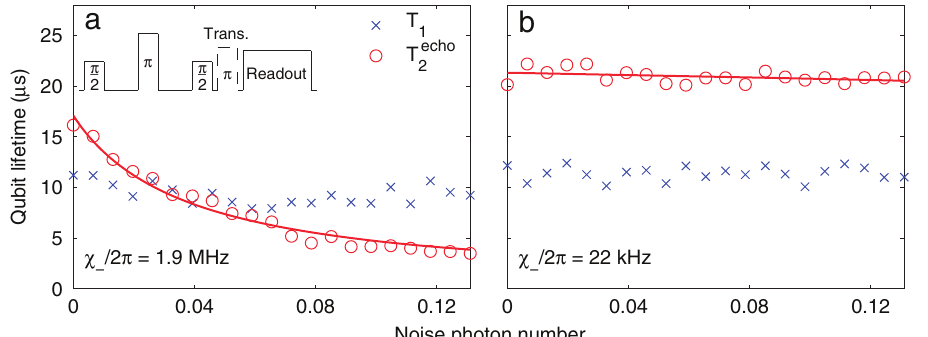
Fig. 4 Qubit relaxation time T 1 ( blue crosses ), dephasing time T 2 with Hahn echo ( red dots ) and fi t to Eq. 3 ( red curves ) as a function of injected photon noise. a When χ − /2 π = 1.9 MHz, T 2 drops from 16 to 3.5 μ s with increasing photon noise. Inset: pulse sequence for T 2 measurement with (without) a transfer pulse for small (large) χ − . b When χ − /2 π = 22 kHz, no drop in T 2 is observed up to noise photon number n th = 0.13